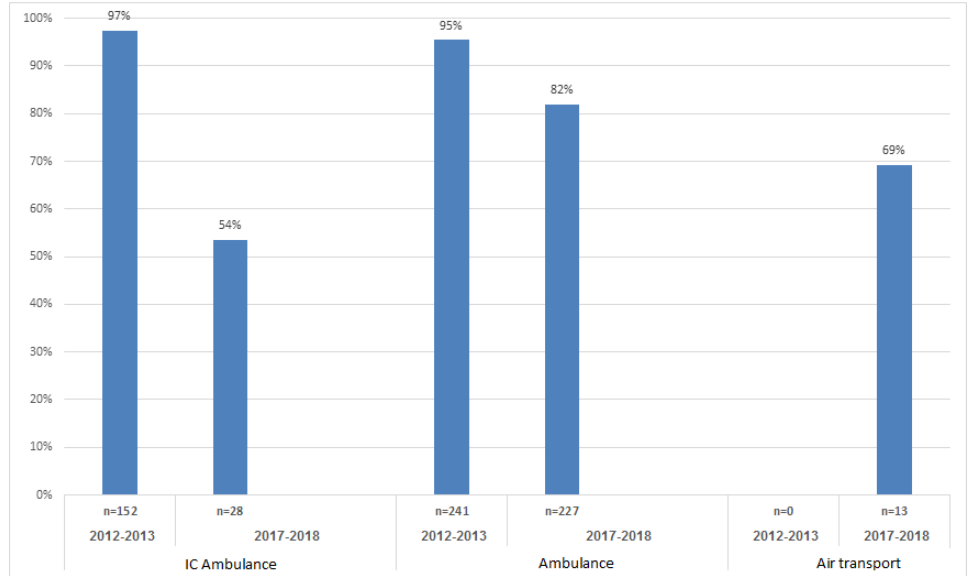
Figure 3. The intensive care (IC) ambulance with the main improvement in field files from the pre- hospital group arriving with the patient. pre-hospital group arriving with the